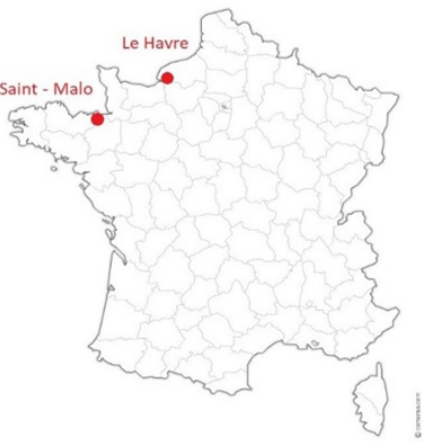
Figure 1. The Saint-Malo and Le Havre